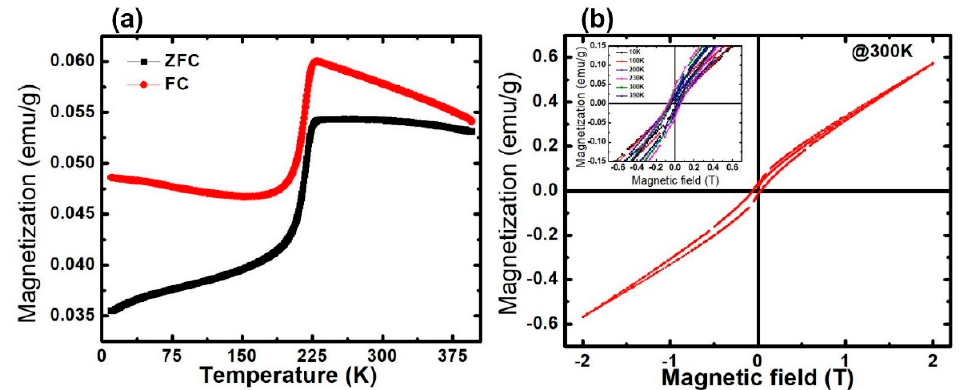
Figure 4. ( a ) Magnetization vs. temperature in FC and ZFC conditions recorded at 1000 Oe. ( b ) Mag- netization vs. magnetic field hysteresis curve at 300 K (inset: magnetization vs. magnetic field at various temperatures (10–390 K) showing M R and Hc).